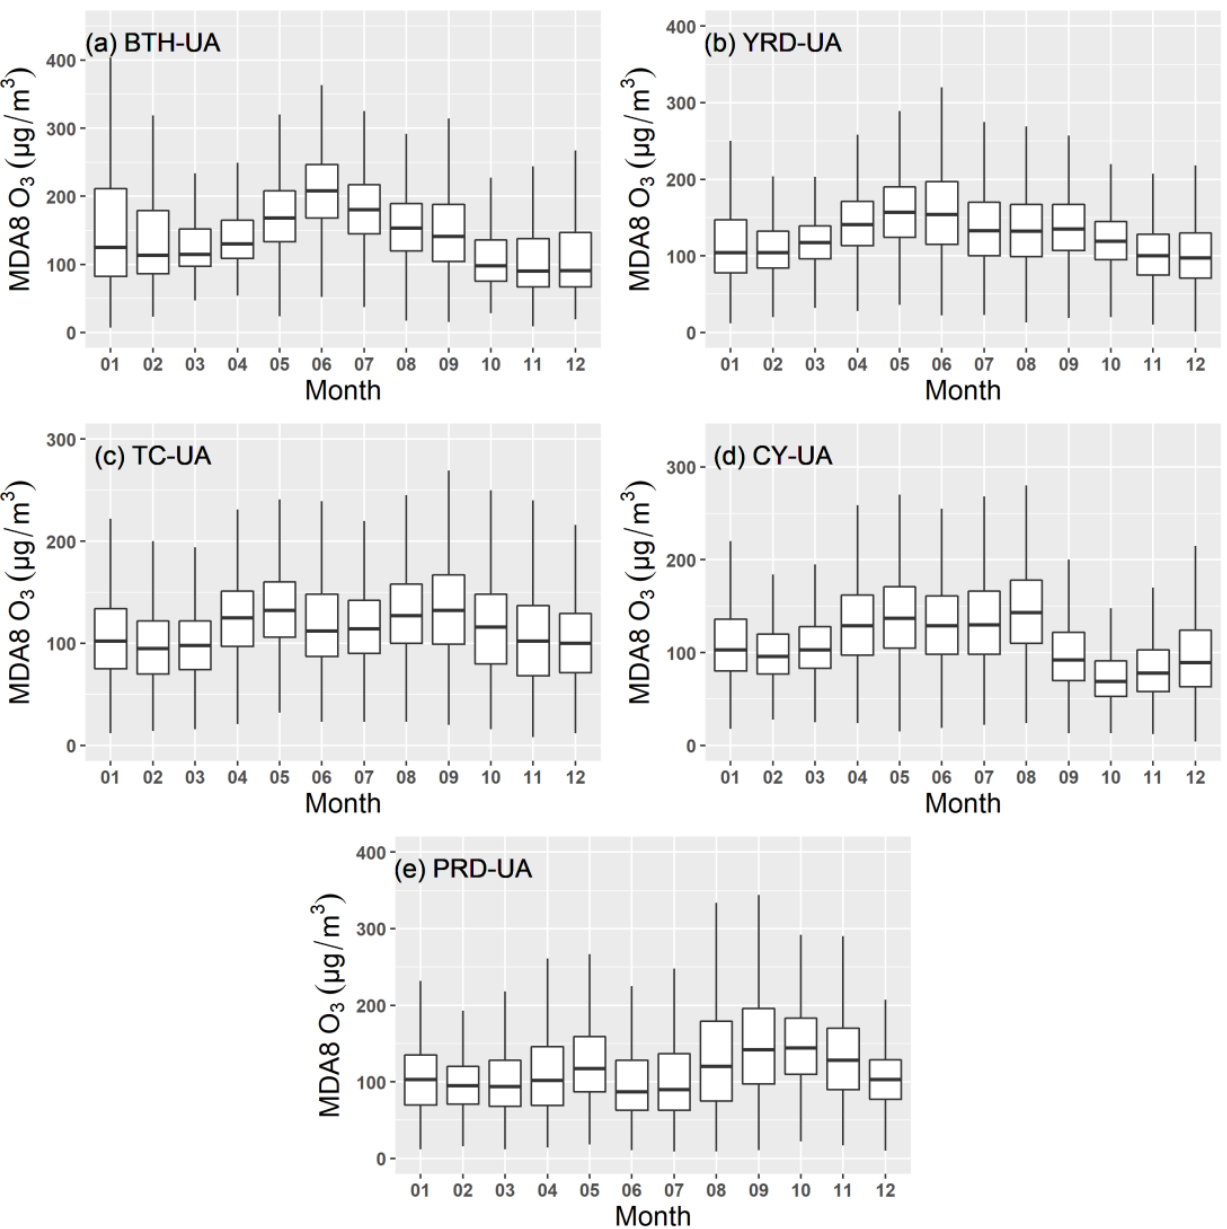
Figure 3. Monthly variation of MDA8 O 3 in ( a ) BTH-UA, ( b ) YRD-UA, ( c ) TC-UA, ( d ) CY-UA, and ( e ) PRD-UA during 2017–2020. Shown are the median (central horizontal bar within the boxes), 25th and 75th percentiles (lower and upper bars of the boxes, respectively), and minimum and maximum (lower and upper whiskers, respectively).